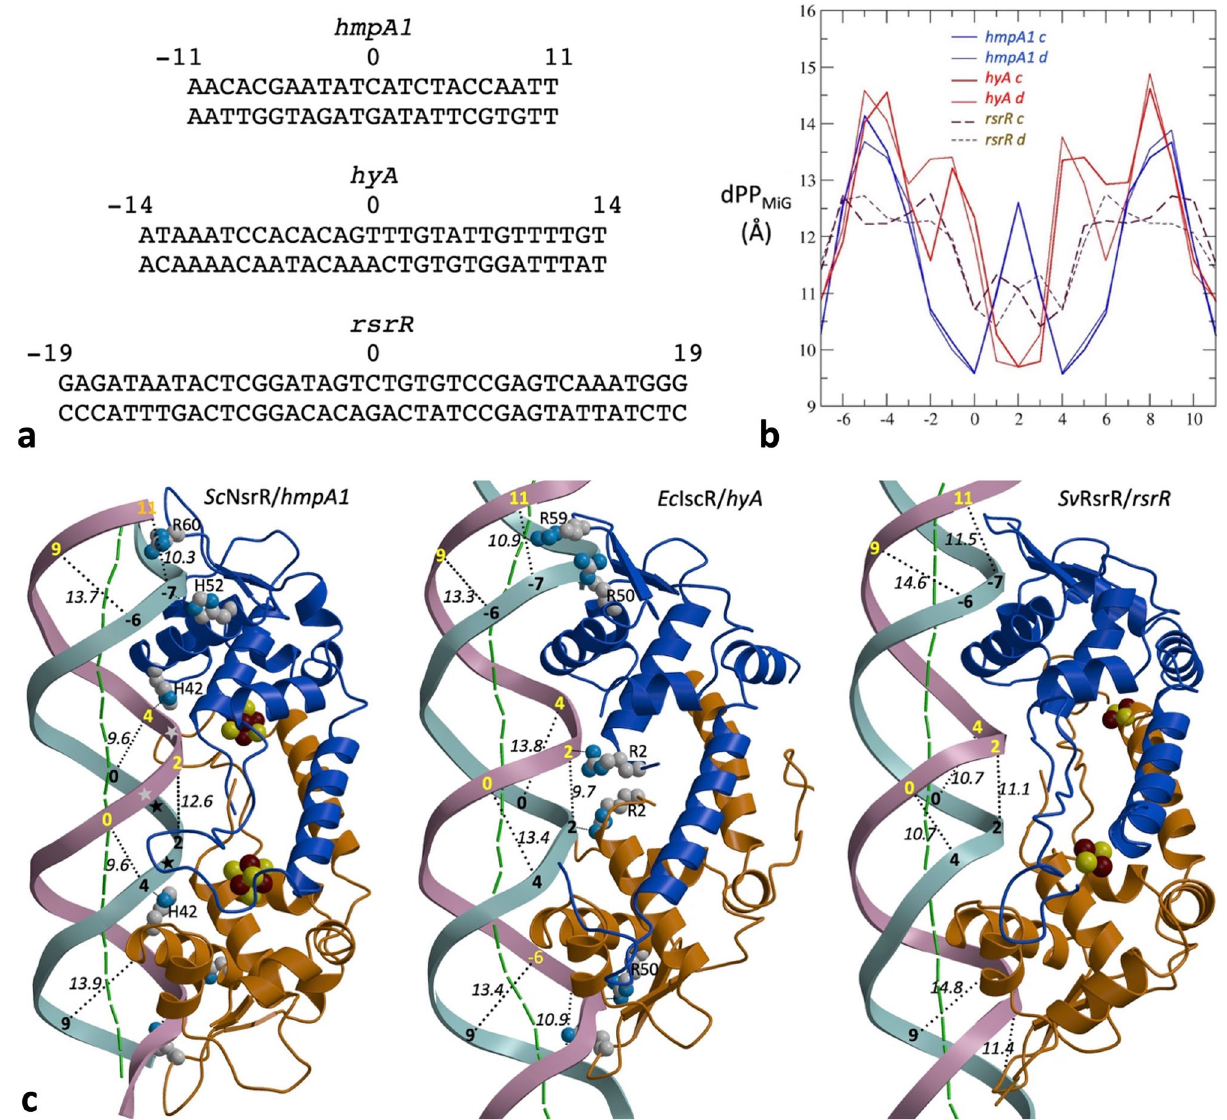
Fig. 6 Shape comparison of the DNA complexes of three Rrf2 family members. a Base sequence alignment of hmpA1 , hyA and rsrR operator fragments in their corresponding complexes with [4Fe-4S]- Sc NsrR, apo- Ec IscR and [2Fe-2S]- Sv RsrR. b Comparison of P-to-P distances (dPP Mig ) in the MiGs of hmpA1 , hyA and rsrR for the phosphate groups in both DNA strands. c Polypeptide and DNA folding of the three labeled complexes in a view perpendicular to that of Fig. 1. Protein subunits, DNA strands and bp tracing, phosphate positions, cluster atoms and amino acids are represented as in Fig. 1. Black dotted lines trace dPP Mig distances (given in Å). Because of its limited resolution, no protein residues are shown for the Sv RsrR-DNA